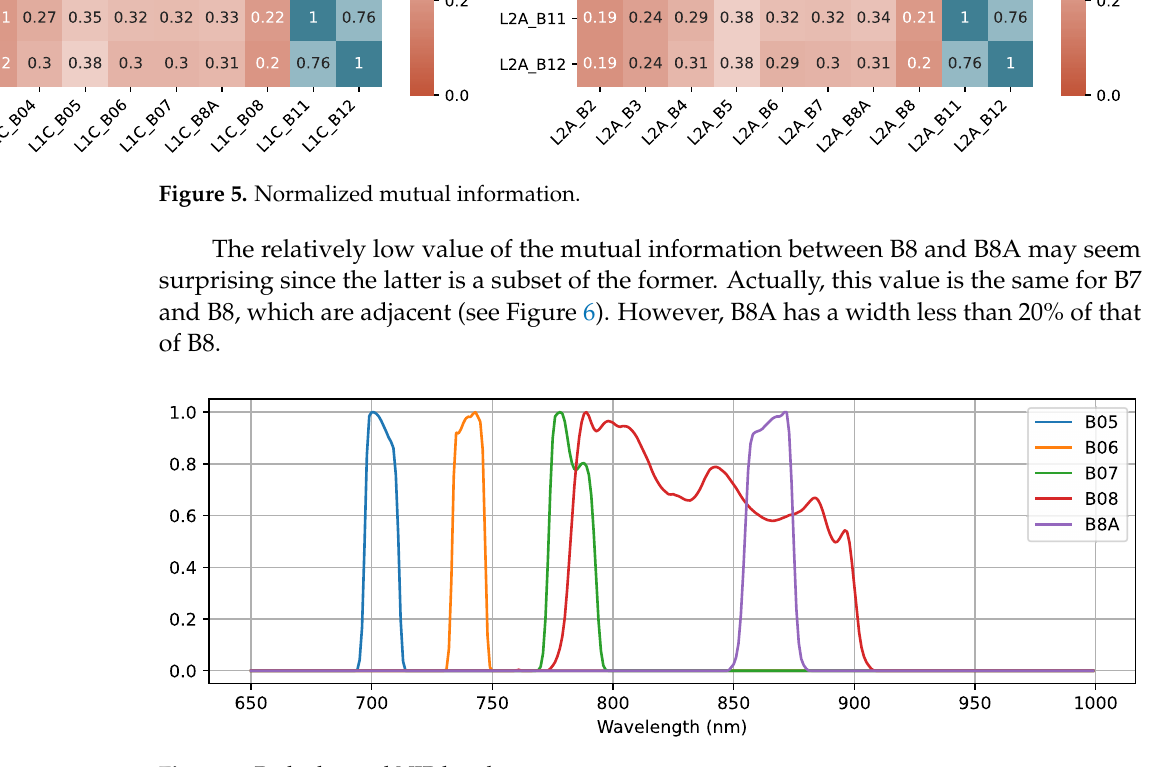
Figure 6. Red edge and NIR